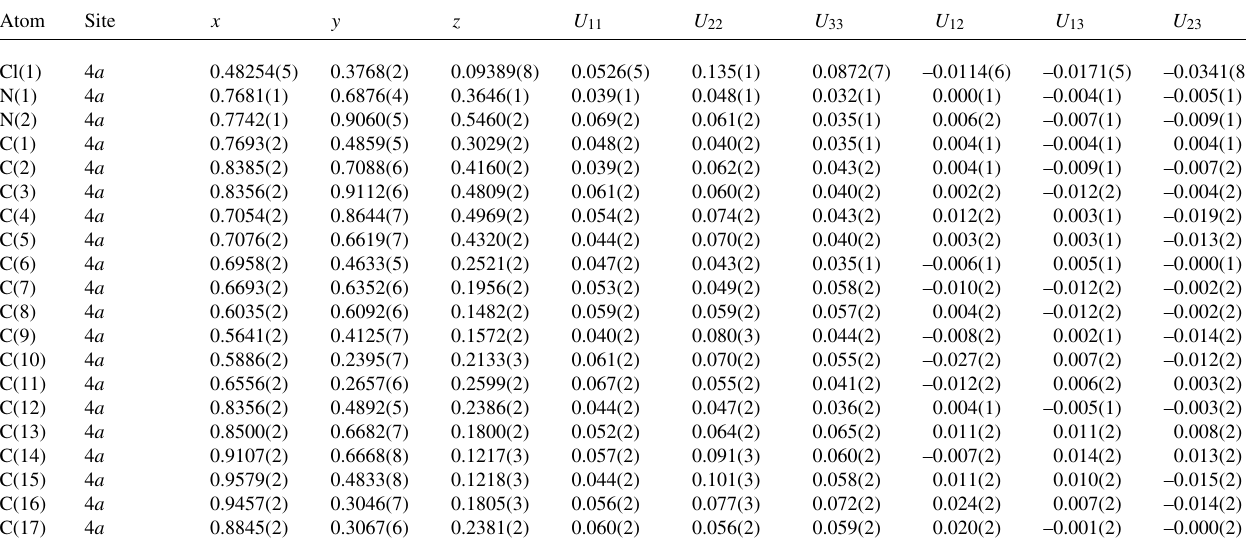
Table 3. Atomic coordinates and displacement parameters (in Å 2 )